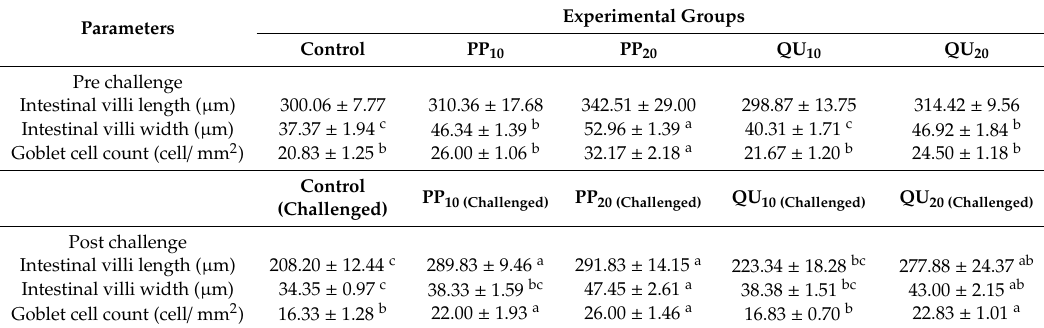
Table 4. E ff ect of the challenge with A. sobria on mortality rate, RPS, liver function and immune status of O. niloticus fish supplemented with PP or QU in di ff erent levels (10% and 20%). Experimental Groups Parameters Control PP 10 PP 20 QU 10 QU 20 Pre challenge Intestinal villi length ( µ